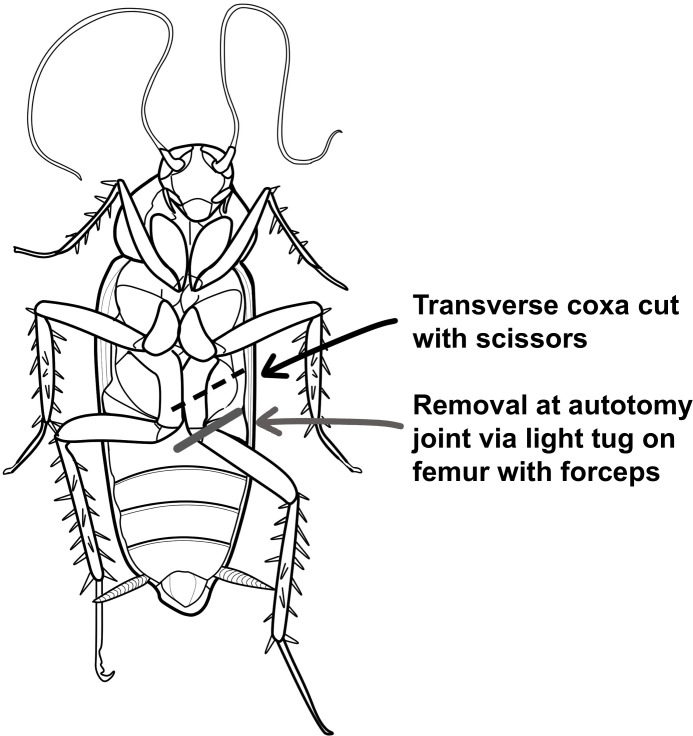
The two different types of leg removal utilized.